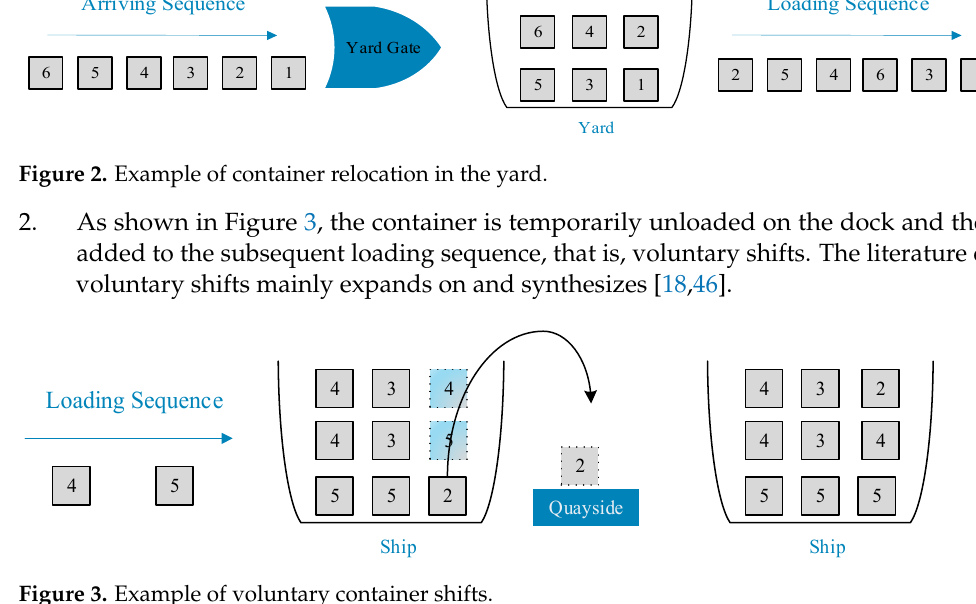
Figure 3. Example of voluntary container